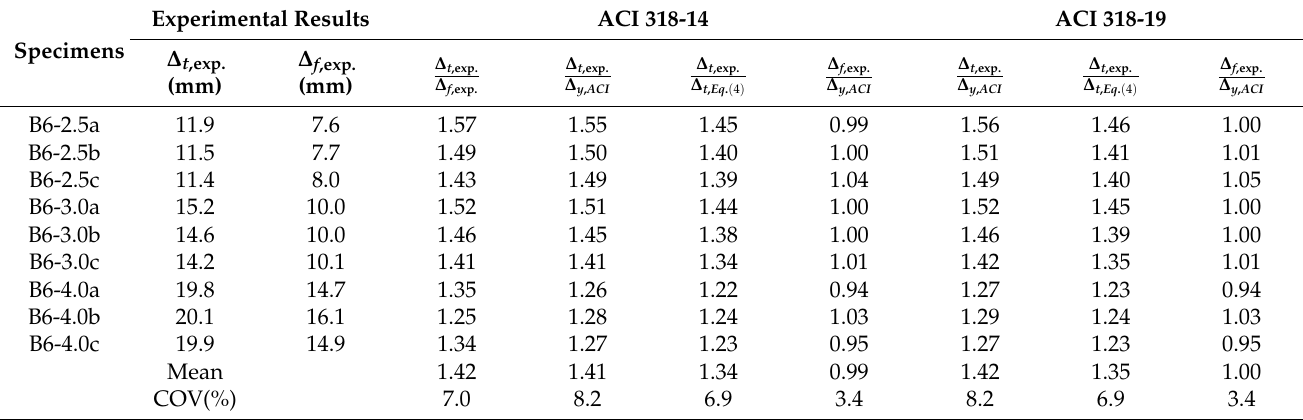
Table 2. Comparison of Experimental and Analytical Results at Flexural Yield.